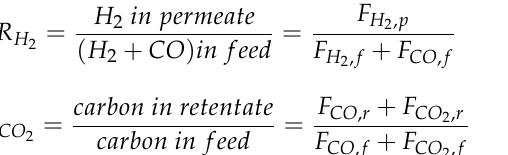
Table 1. Component permeance ( Q i,o ) values used reported in gas permeation units (GPU).